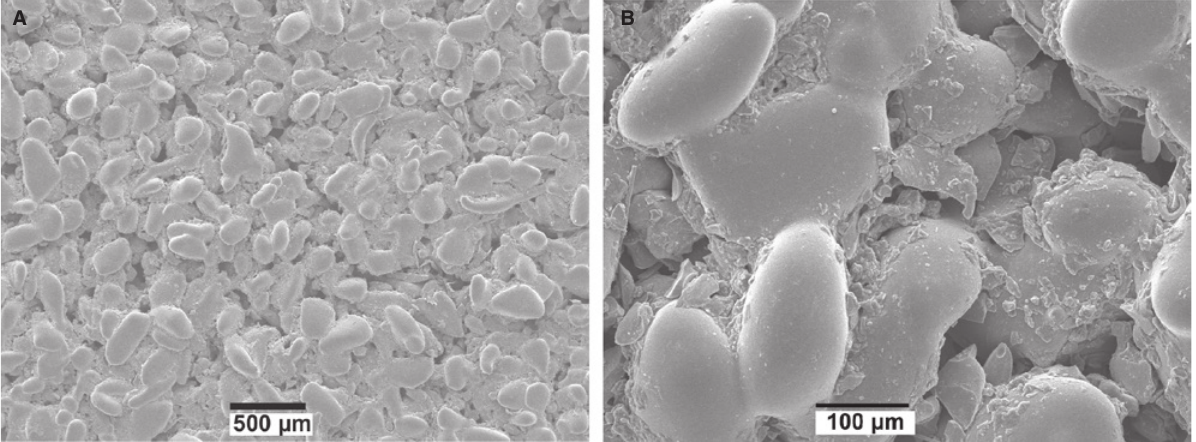
Figure 8: SEM images of MG80 recycled glass sintered at 750 ° C for 25 min: (A) low and (B) high